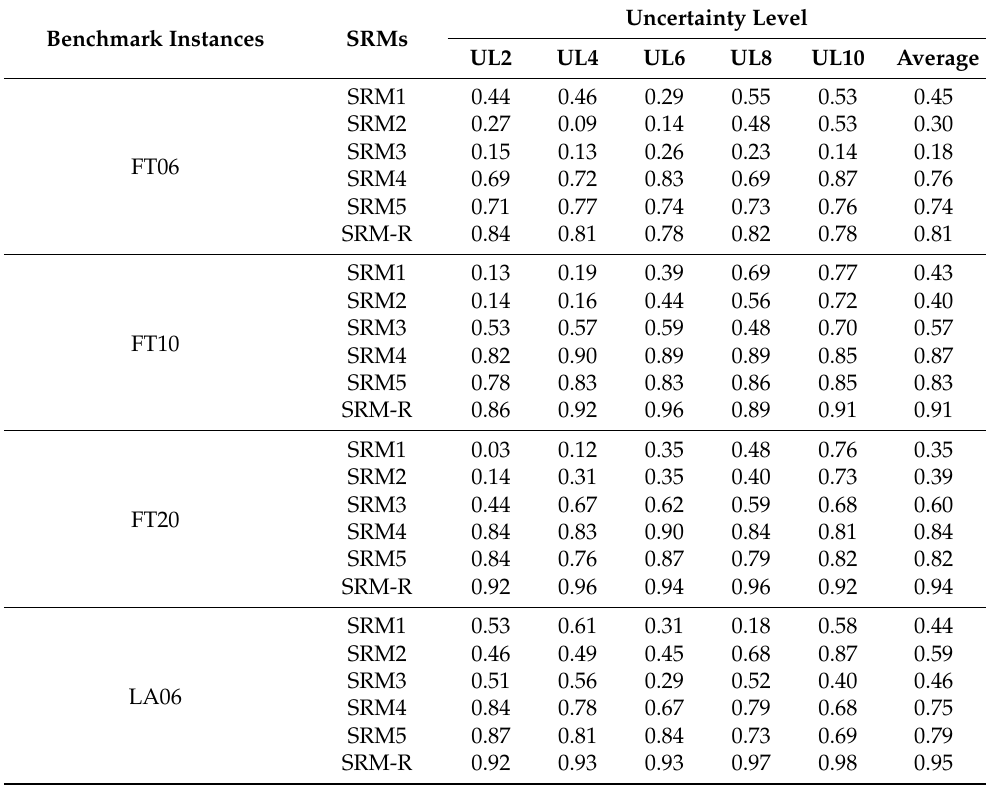
Table 3. The R 2 value of the comparison SRMs. Benchmark